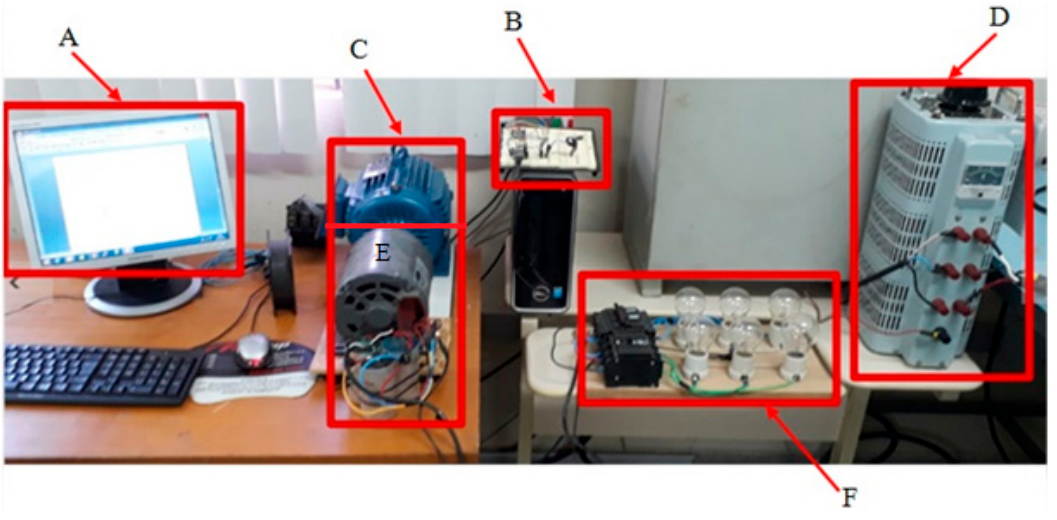
Figure 10. Experimental Bench. ( A ) Computer Monitor; ( B ) Receiver Circuit; ( C ) Motor.; ( D ) VARIAC; ( E ) Generator; ( F ) Load (Lamps).